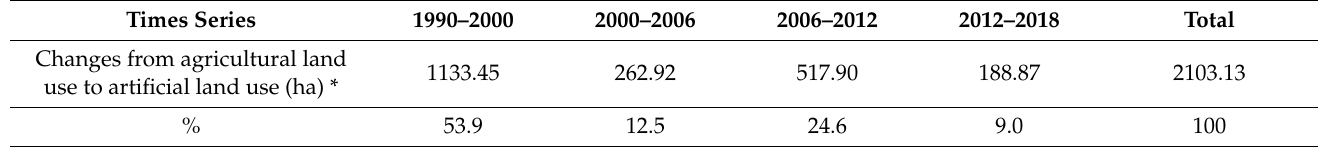
Table 1. Agricultural land-use change in artificial land-use in times series from 1990 to 2018 (in ha). Times